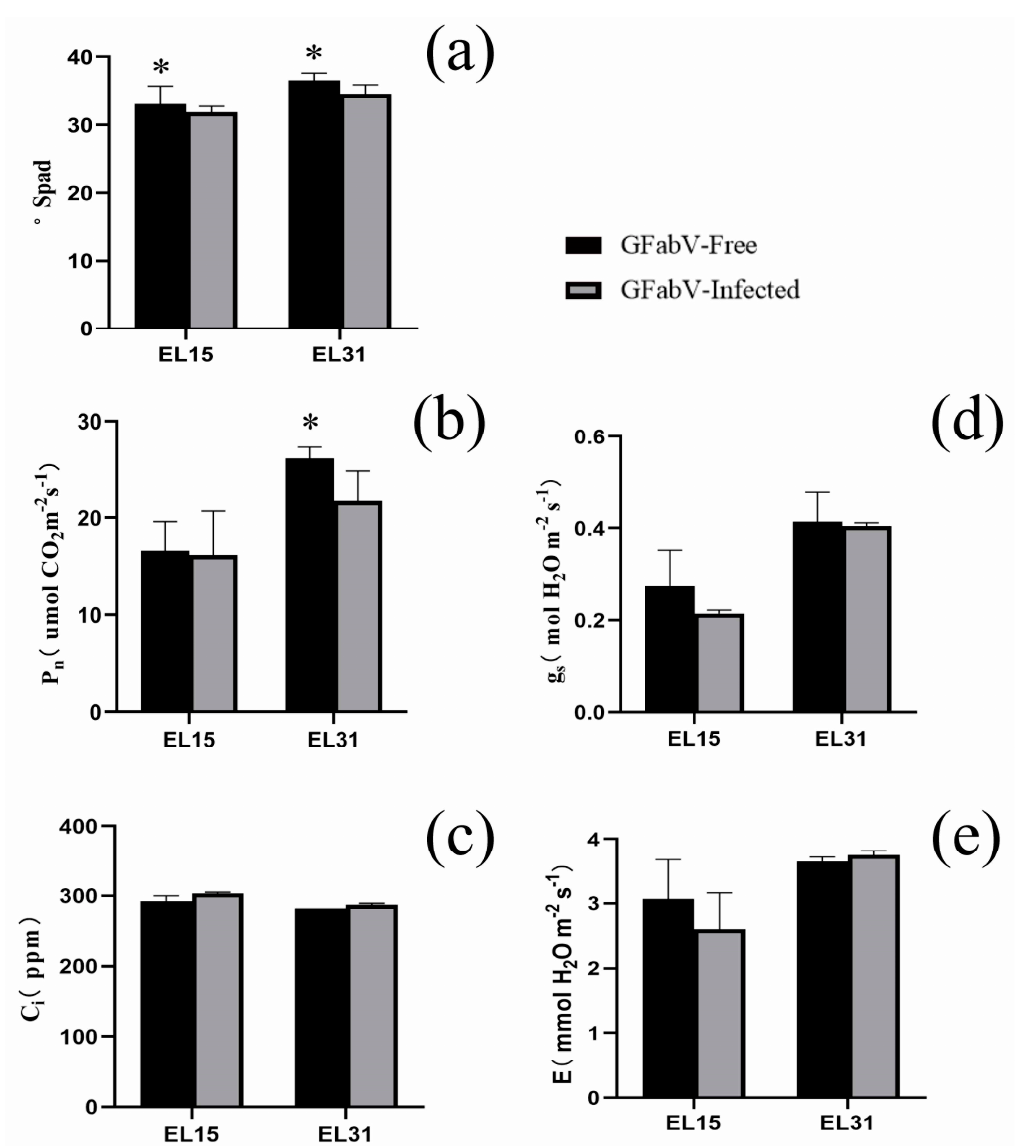
Figure 2. Comparison of ( a ) chlorophyll content (Spad), ( b ) net photosynthesis (P n ), ( c ) intercellular CO 2 concentration (c i ), ( d ) stomatal conductance (g s ), and ( e ) transpiration (E) in GFabV-free (black columns) and GFabV-infected (grey columns) in grapevine leaves in 2019. Measurements (n = 3) were conducted in two phenological periods: EL15 and EL31. Bars represent the standard error (SE). Statistically significant results are indicated with asterisks, p < 0.05.